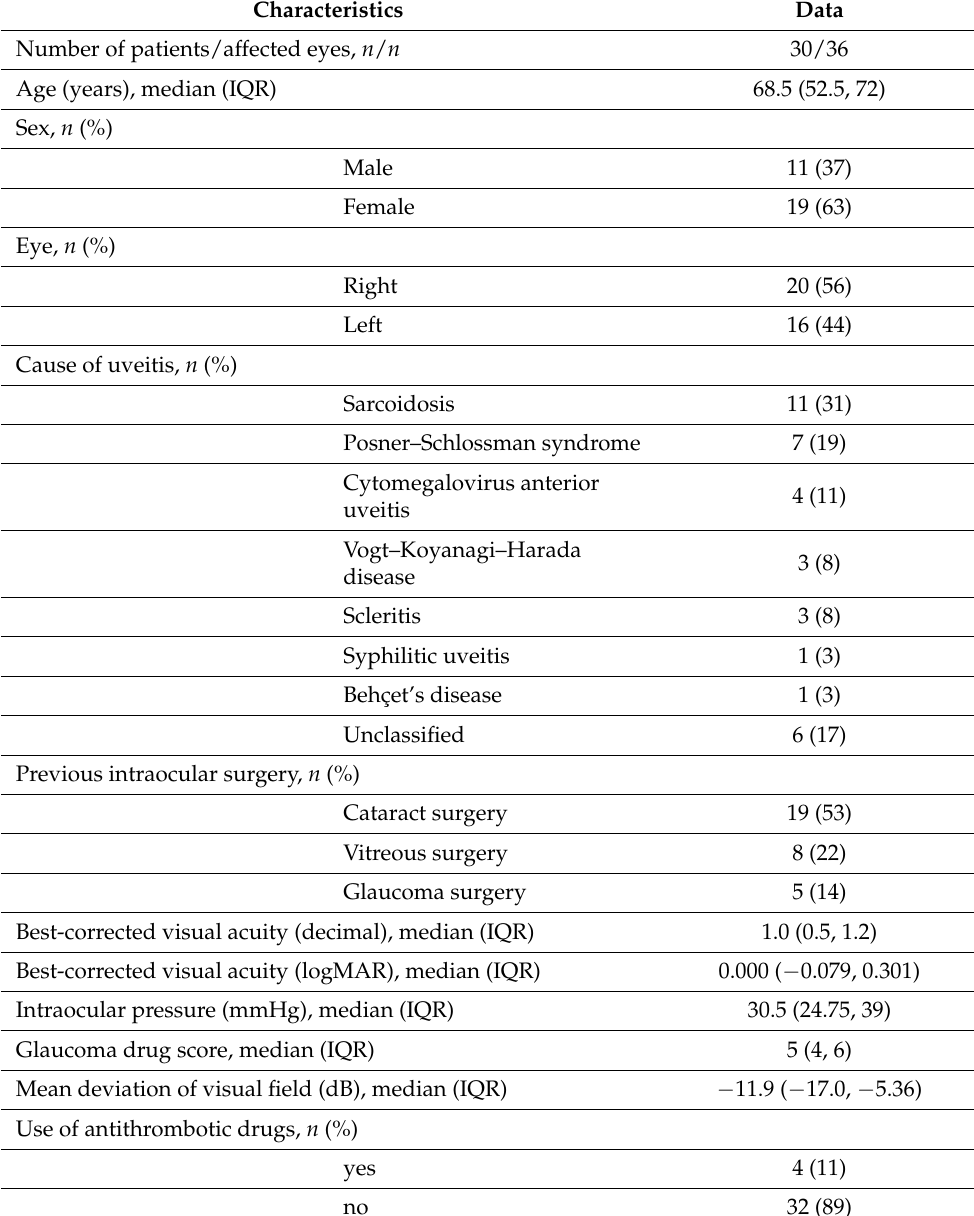
Table 1. Patient Preoperative